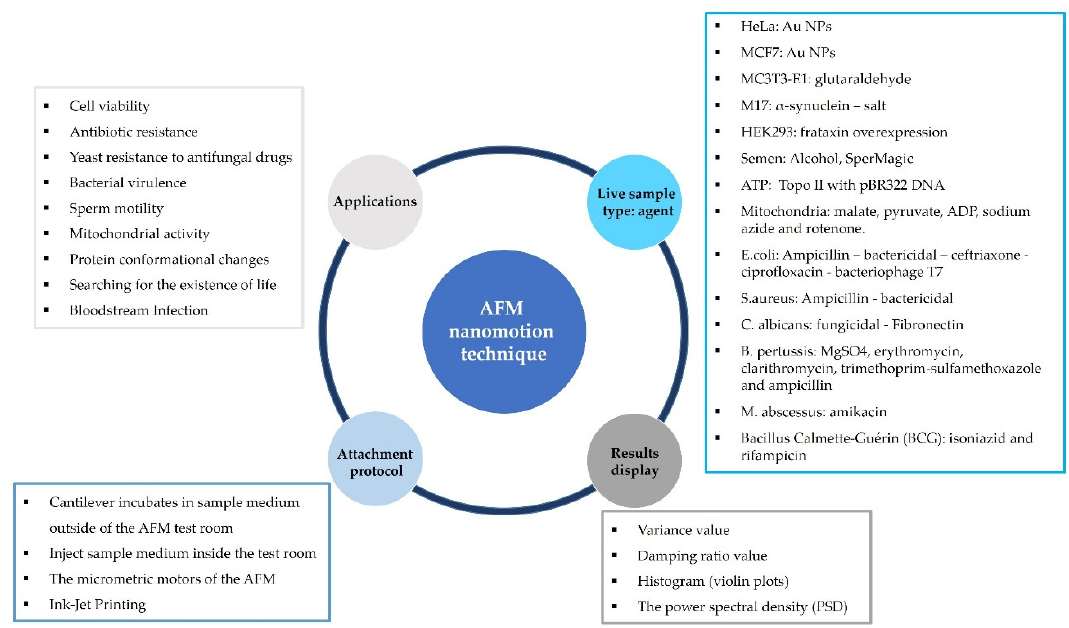
Figure 5. The AFM nanomotion technique. Different applications of nanomotion technology have been used for several types of living samples with different chemical agents. Different protocols were used to adhere the sample to the cantilever surface. Different display methods were used to present the results.